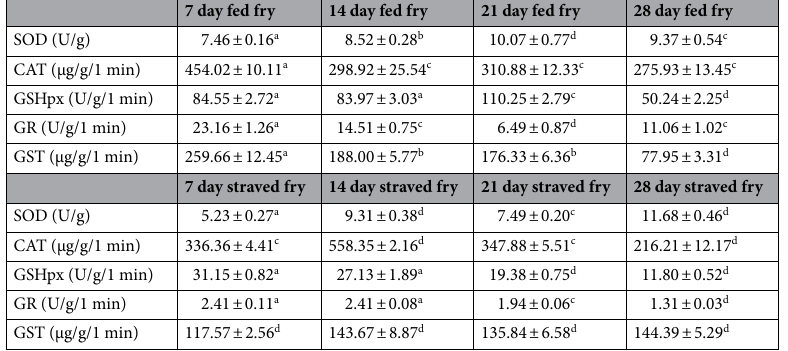
Table 1. Changes in antioxidant enzymes, superoxide dismutase (SOD), catalase (CAT), glutathione peroxidase (GSHpx), glutathione reductase (GR) and glutathione S -transferase (GST) activities in 7, 14, 21 and 28 days fed and starved fry of Oncorhynchus mykiss .* *Each value is the mean ± S.E. (standard error) of 3 repetitions. Superscripts after values in a same line with different letters represent significant difference. a Values of P > 0.05 is not statistically significant. b Values of P < 0.05 is statistically significant. c Values of P < 0.01 is statistically more significant. d Values of P < 0.001 is statistically most significant.